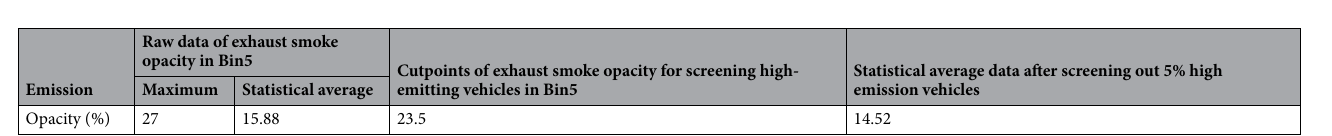
Table 4. Screening threshold of exhaust opacity for detecting high-emitting vehicles in Bin5.